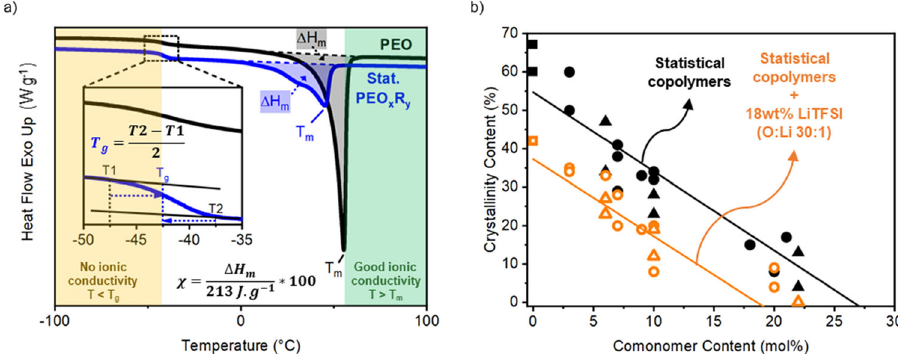
Fig. 2 Thermal characterization of materials. a Thermogram for polyethylene oxide (PEO) (black curve) and for a typical statistical copolymer (blue curve). b Crystallinity content versus comonomer content, for statistical copolymers with (orange) and without (black) 18 wt% lithium bis- (tri fl uoromethanesulfonyl)imide (LiTFSI), where squares are for PEO, circles are for copolymers of ethylene oxide with propylene oxide (PEOPO) and triangles are for copolymers of ethylene oxide with 1,2-butylene oxide (PEOBO). COMMUNICATIONS MATERIALS| (2021) 2:83